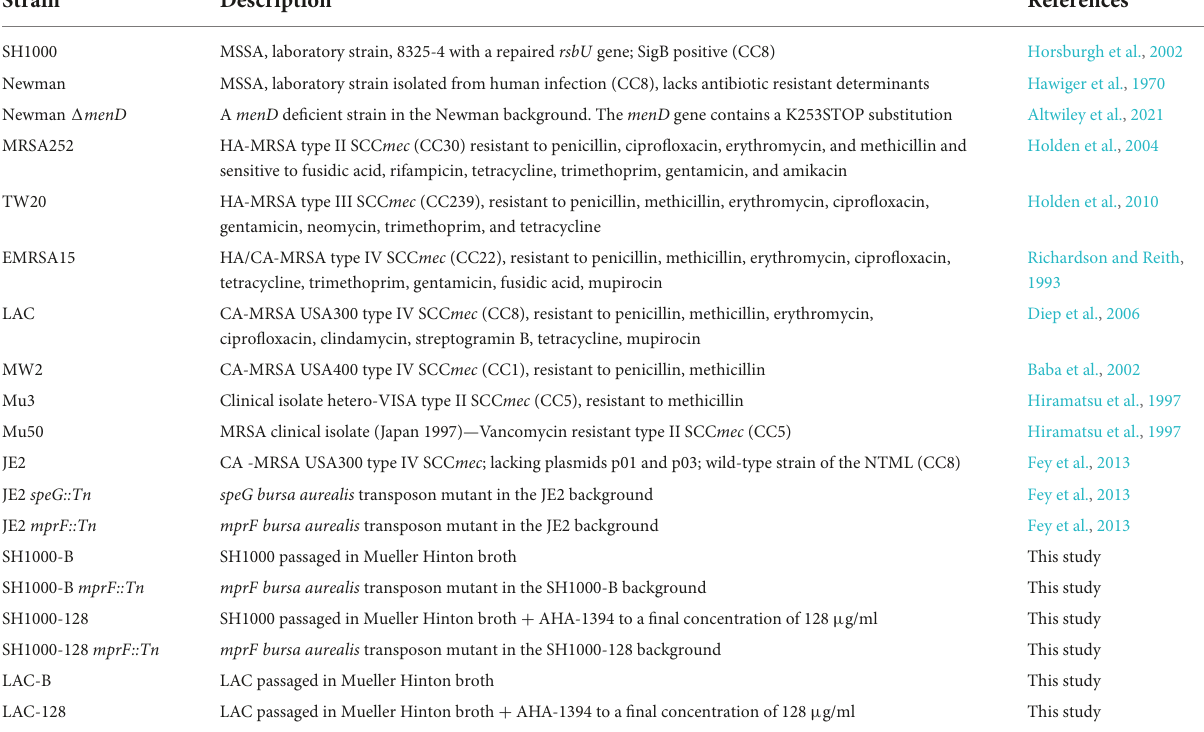
TABLE 1 List of strains used in this